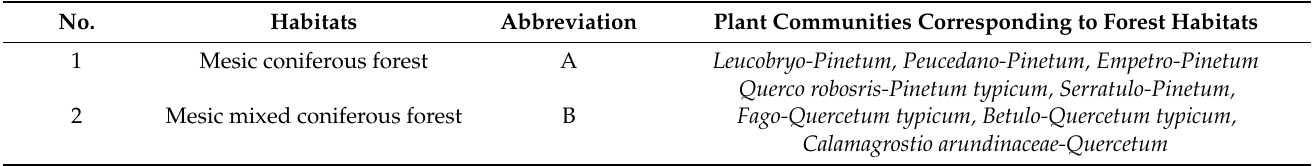
Table 1. Habitats from which the plant material originated, listed ranging from the poorest to the most fertile along with corresponding plant